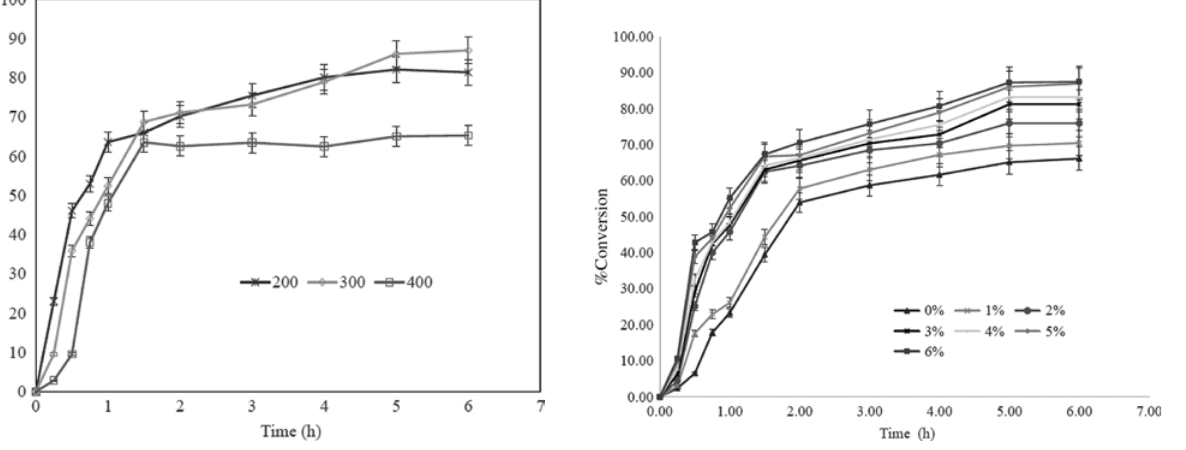
Figure 4: Influence of speed of agitation on reaction conversion at stearic acid to PEG 600 ratio 1:4: temperature 70 ° C, enzyme loading Fermase 0.5% (w/w), and molecular sieves 5%.